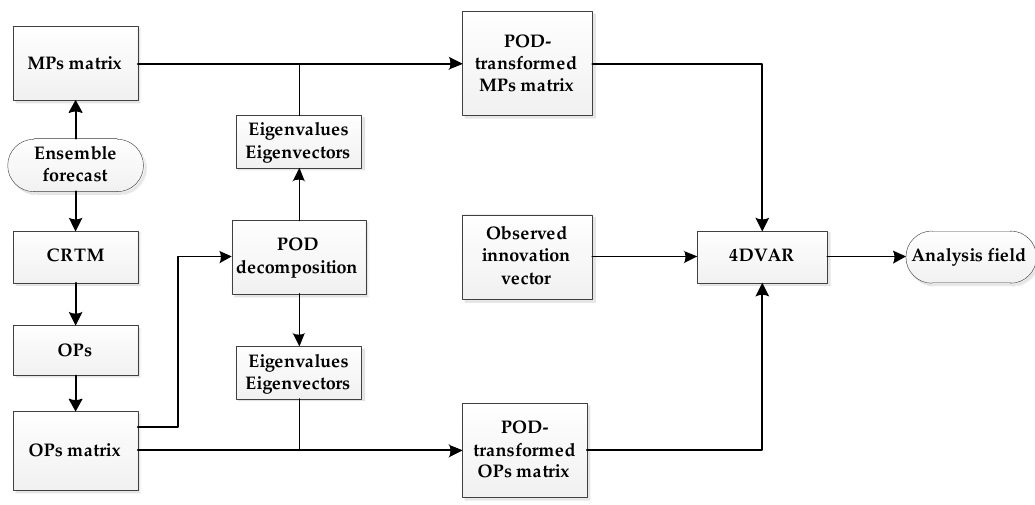
Figure 2. Flowchart of the POD-4DEnVar Satellite Assimilation System.